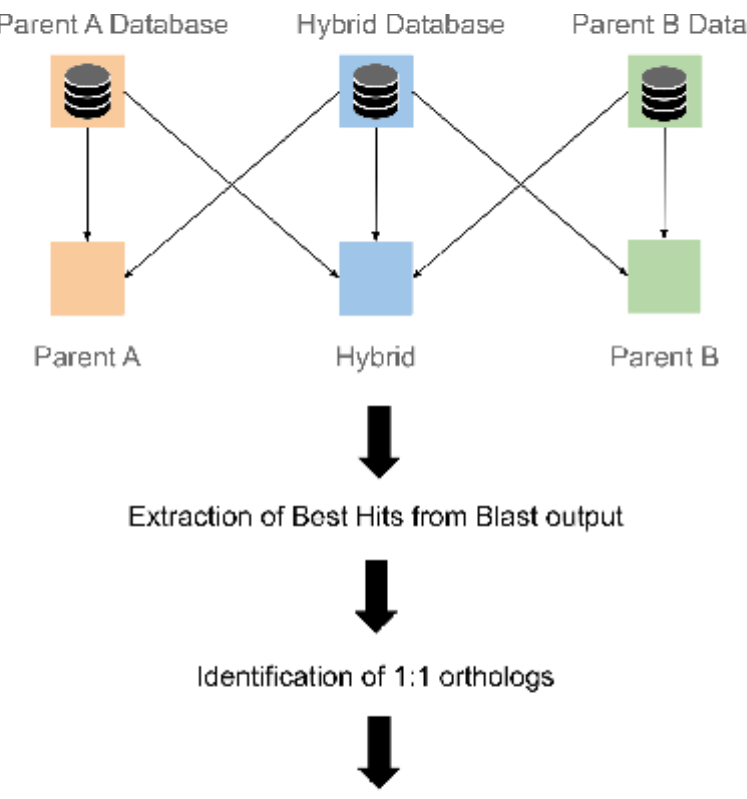
Figure 2. HybridMine pipeline. The execution steps are indicated by the bold arrows. Firstly, three Blast databases are created for the hybrid and the parental species. Genes of the hybrid are blasted against all the databases and the parents are also blasted against themselves. Secondly, best hits are extracted from each Blast output and are used in the next step to determine the one-to-one orthologs between the hybrid and the parents, and the homolog genes in each genome. Parental alleles in hybrid genome are then identified from the one-to-one orthologs. Finally, the homolog genes in the hybrid are annotated with the parental alleles.